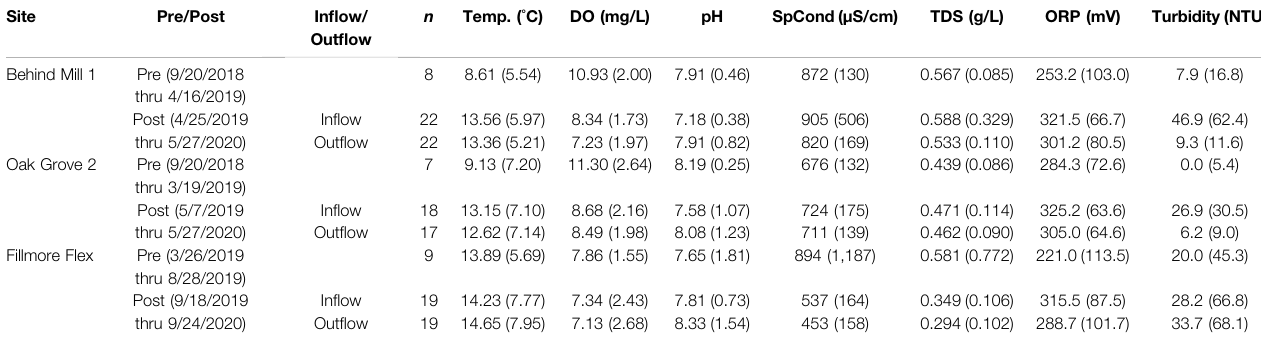
TABLE 1 | Mean (1 standard deviation [SD]) values of selected water quality parameters for tile drain in/out fl ow iron slag pre- and post-installation monitoring. Date of fi rst sampling is provided below each Pre/Post. Data are shaded to improve readability. n = number of successful sampling events per site, abbreviations in main text.